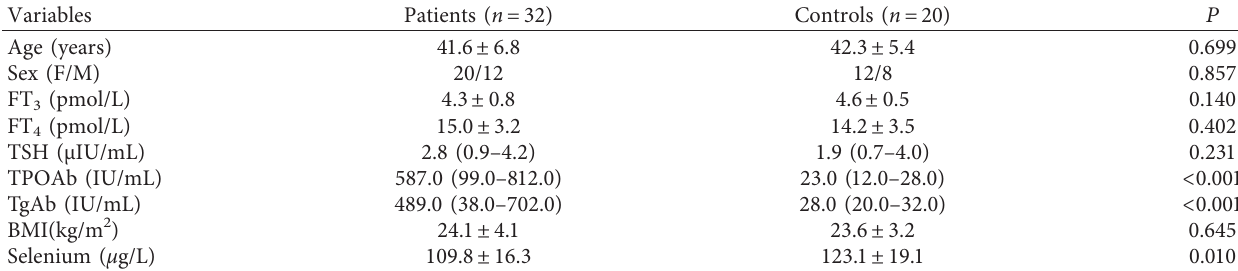
Table 1: Demographic and clinical data in patients with autoimmune thyroiditis and healthy controls.